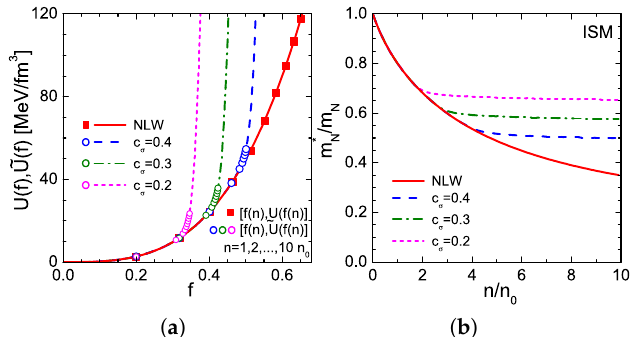
U ( f ) in the (cid:101)